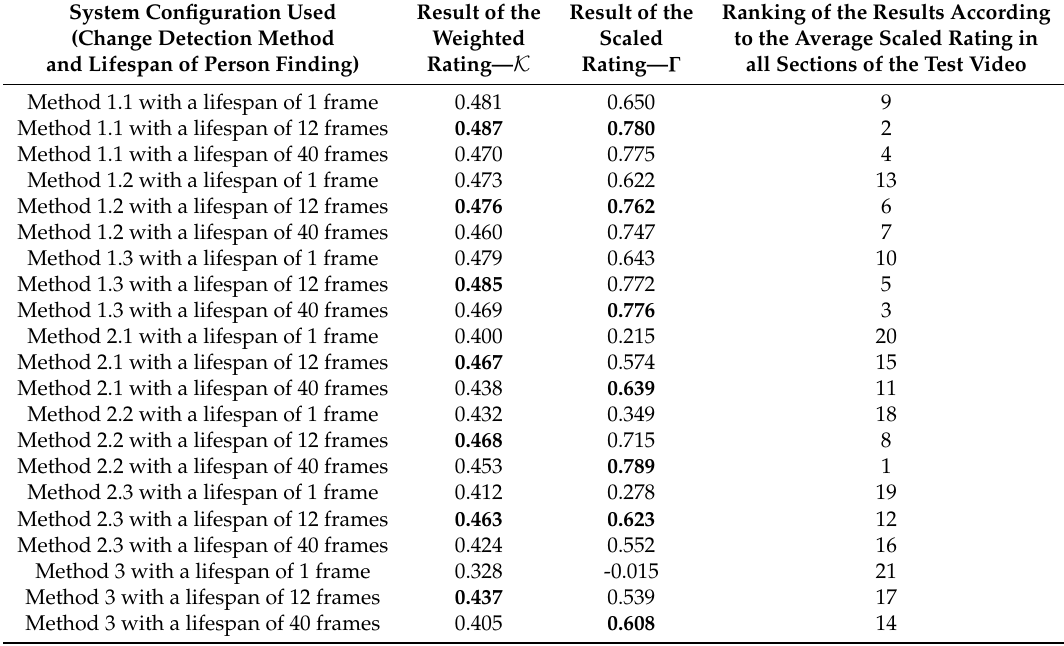
Table 5. Table of sorting the tested system configurations according to the average scaled rating in the test video sections, from